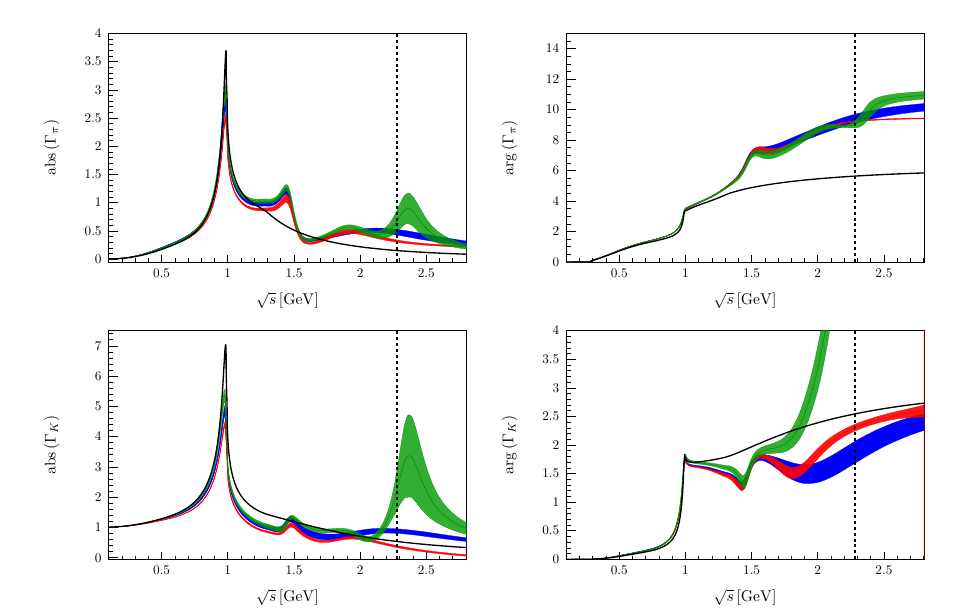
Figure 2. Modulus (left) and phase (right) of the extracted pion (top) and kaon form factor (bottom) with an additional ρρ channel. We see Fit 1 in blue, Fit 2 in red, and Fit 3 in green. The dotted lines correspond to the kinematic energy range available in the ¯ B 0 Omnèssolution as a black solid